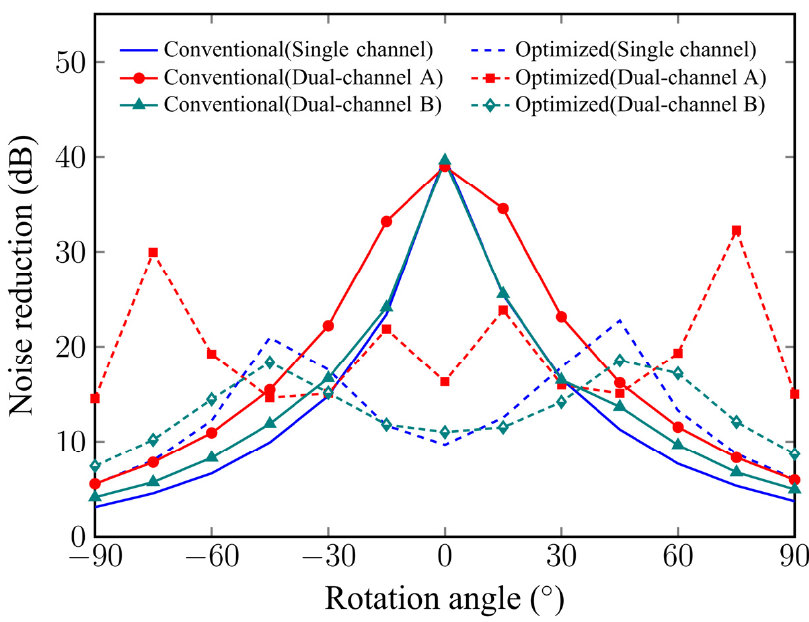
Figure 8. Noise attenuation with transfer response model optimization when head rotates. Single channel stands for single channel system, Dual-channel A for dual-channel system with layout A and Dual-channel B for dual-channel system with layout B.